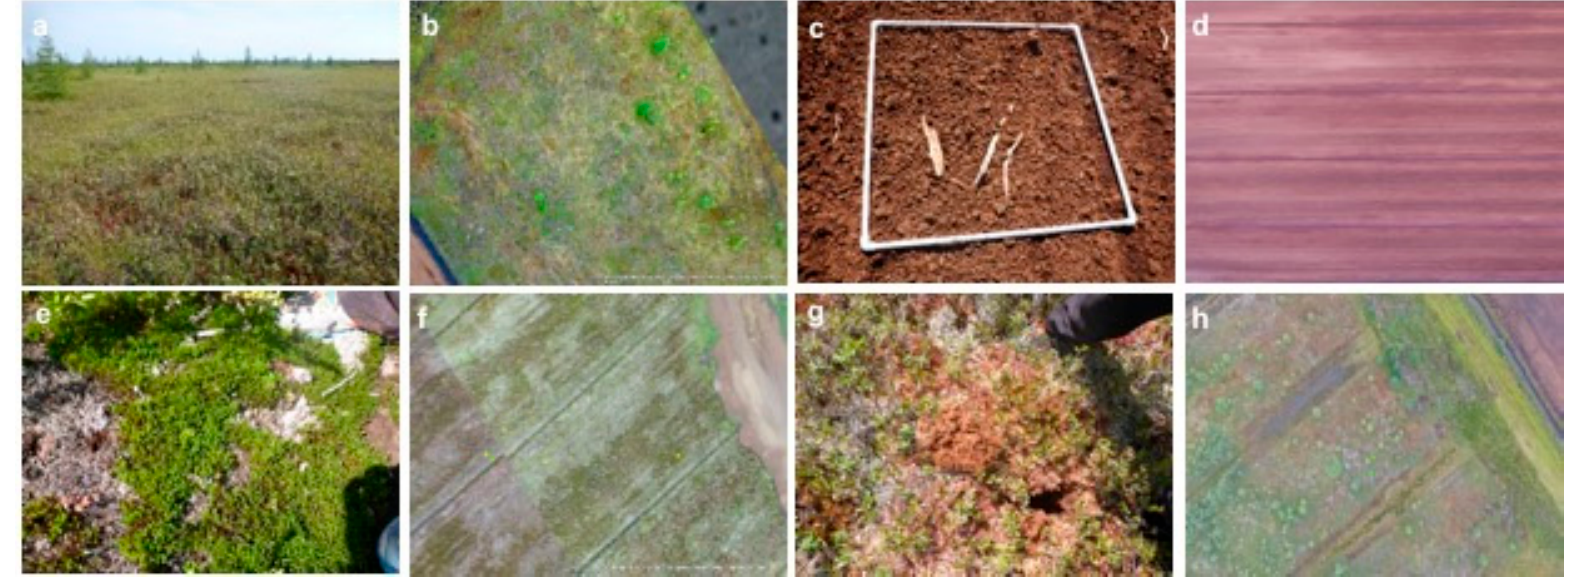
Figure 11. Sainte-Marguerite-Marie peatland field site photos and UAS imagery. Photos ( a ) representative natural bog, ( b ) UAS imagery for the natural bog, ( c ) exposed peat layer prepared for harvest, ( d ) UAS imagery for harvest area, ( e ) post-restoration area with Polytrichum cover, ( f ) UAS imagery for Polytrichum covered area, ( g ) Predominantly Sphagnum moss-covered site, and ( h ) UAS imagery for a Sphagnum covered area.